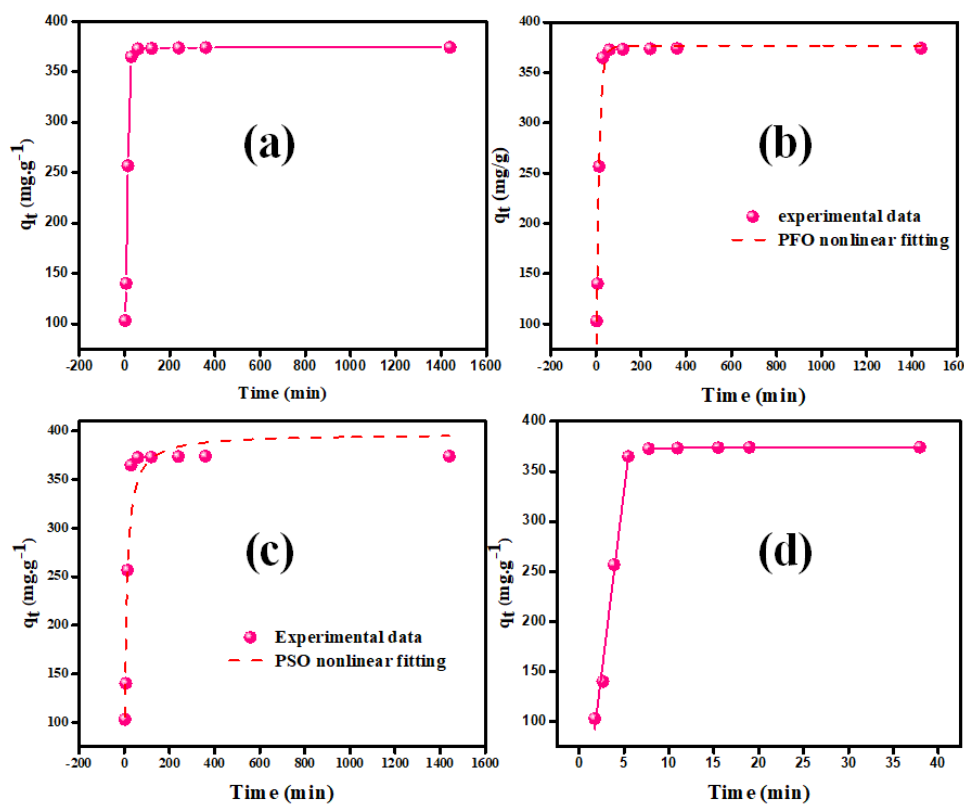
Figure 8. ( a ) Equilibrium time study ( b ) PFO, ( c ) PSO and ( d ) Intra-particle diffusion graphs for the uptake of BF onto CaO-g-C 3 N 4 .